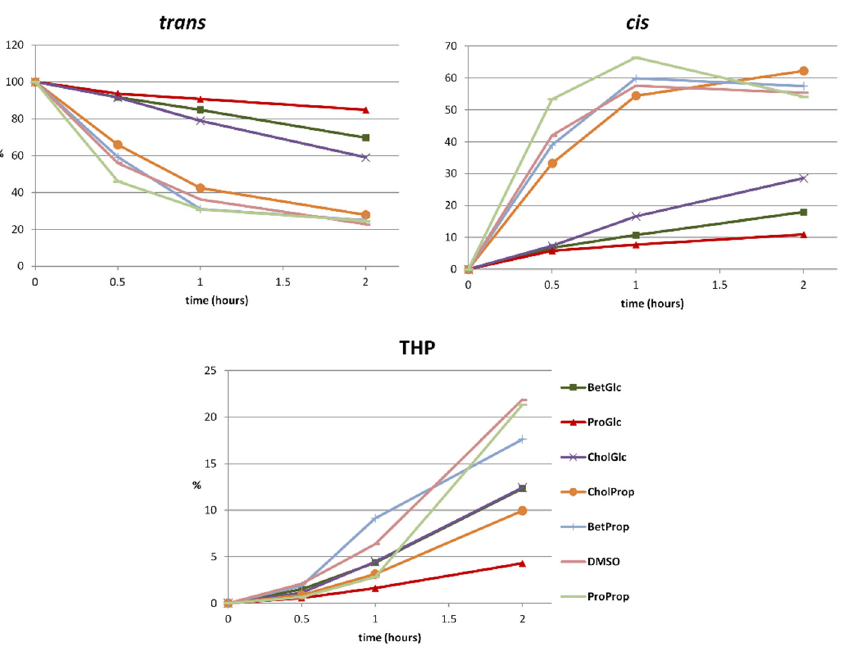
Figure 6. Resveratrol UV-light-induced photochemical isomerization and THP formation in the presence of different NaDES. DMSO was utilized as the control solvent.